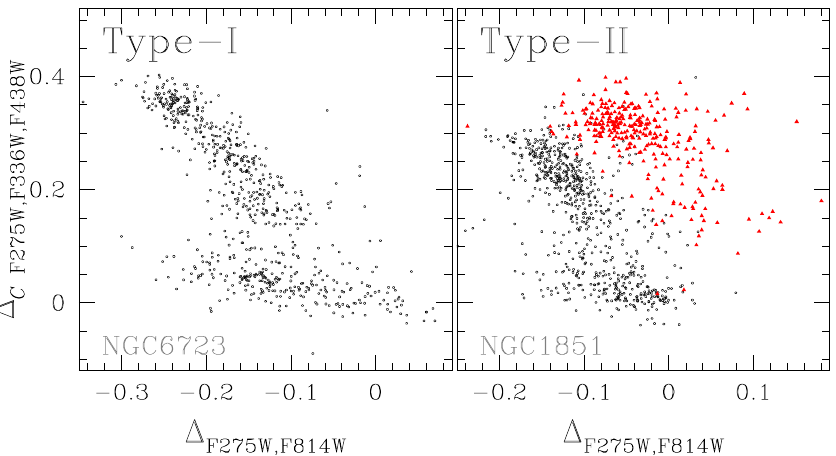
Figure 3. Chromosome maps of NGC6723 ( left ) and NGC1851 ( right ), which are prototypes of TypeI and TypeII GCs. Red symbols mark the red-RGB stars of NGC1851. Photometry is from Milone et al.